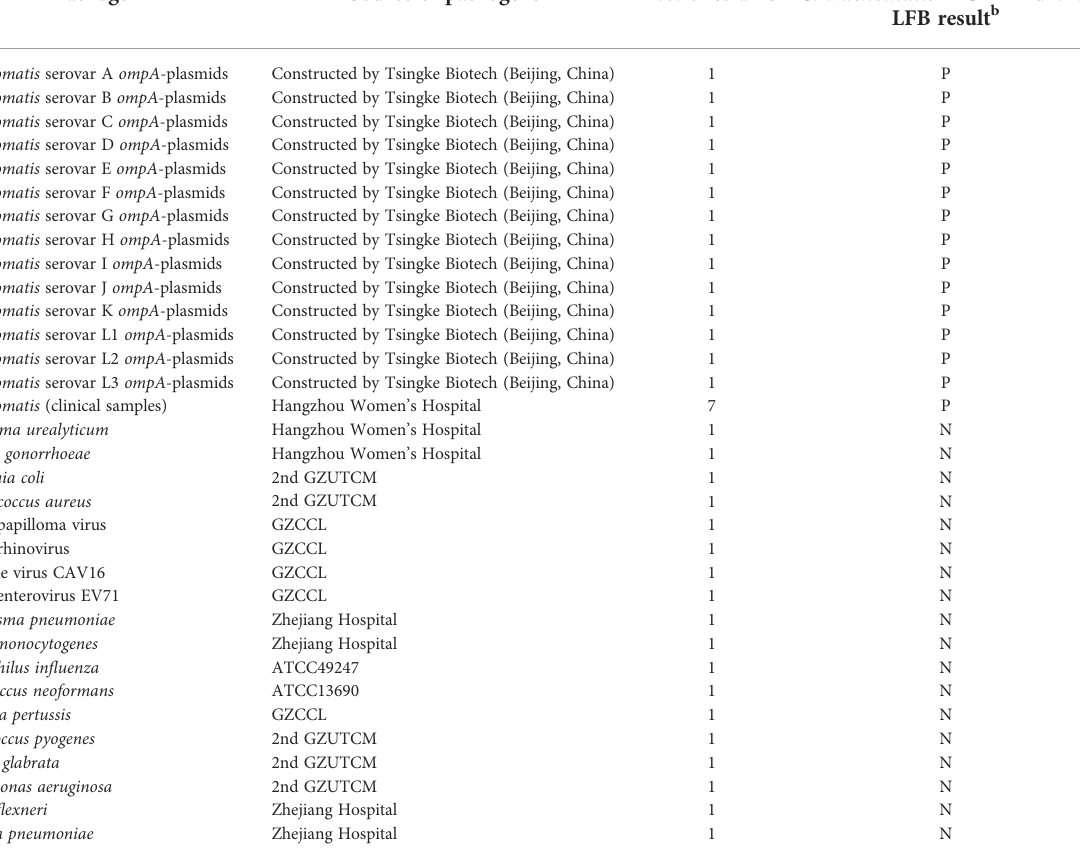
TABLE 1 Microbial strains used in this study. No. Pathogen Source of pathogens a No. of strains C. trachomatis